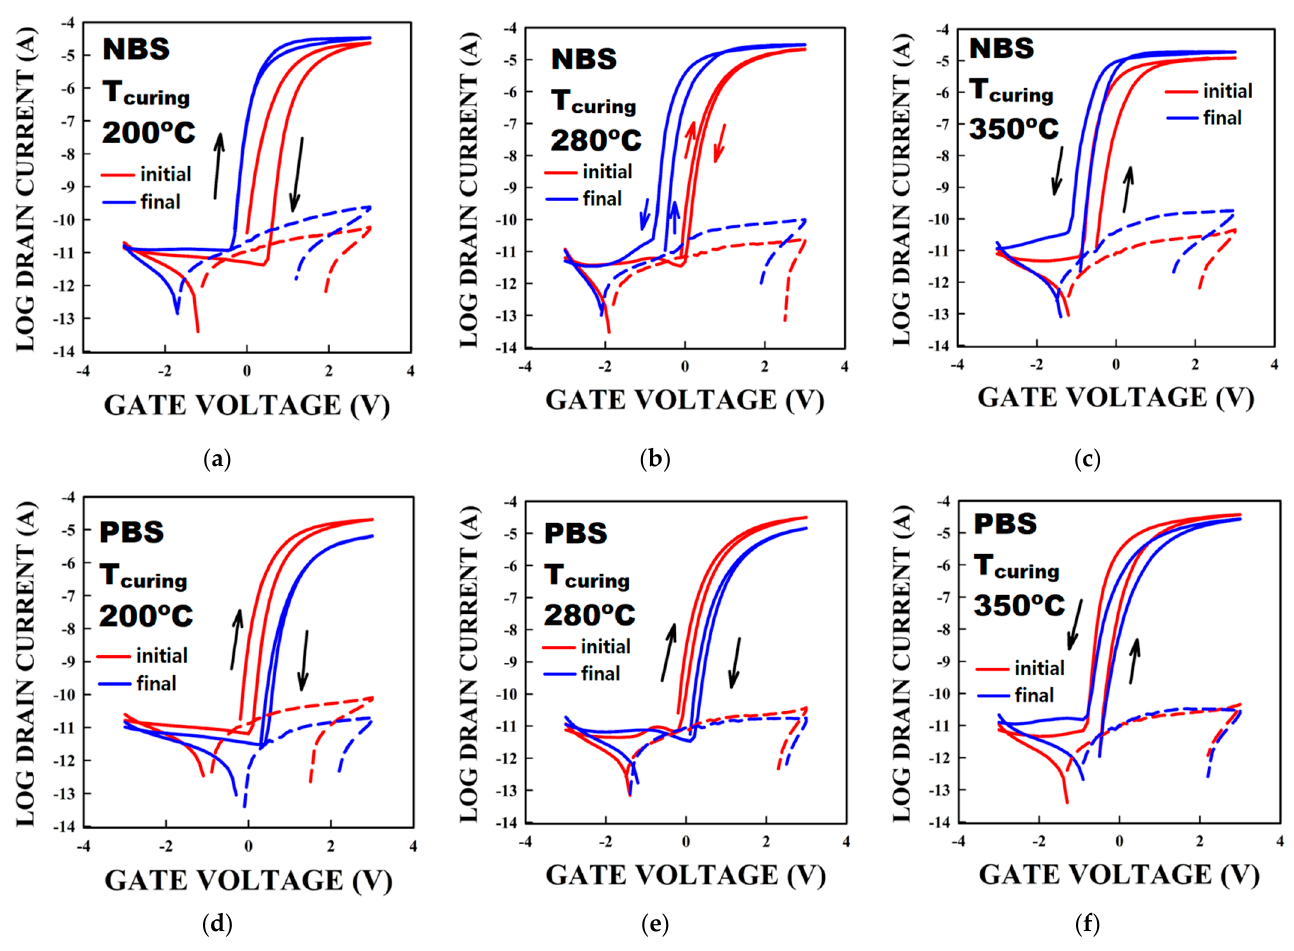
Figure 4. Evolution of the hysteresis curve of SnO 2 TFT under negative and positive bias stresses for a typical TFT with a SnO 2 layer made at a T curing of ( a , d ) 200, ( b , e ) 280, ( c , f ) 350 °C, respectively. The solid (dash) line refers to I DS (I GS ) measured at V DS = 0.1 V. Black arrows indicate the direction of the hysteresis in all graphs except in ( b ) where the red (blue) arrows indicate the direction of the hysteresis at the beginning (the end) of the stress. All stresses were during 3600 s. All hysteresis curves were measured under slow rates.